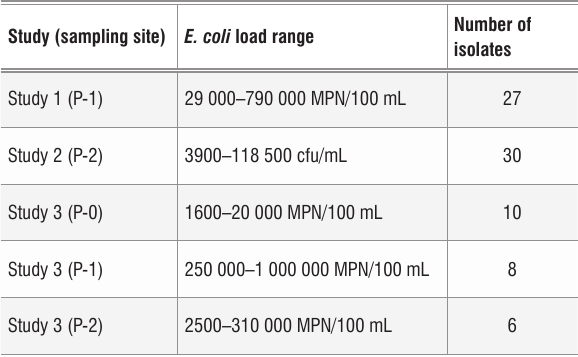
E. coli load ranges in the Plankenburg River and number of confirmed E. coli isolates Study (sampling site)